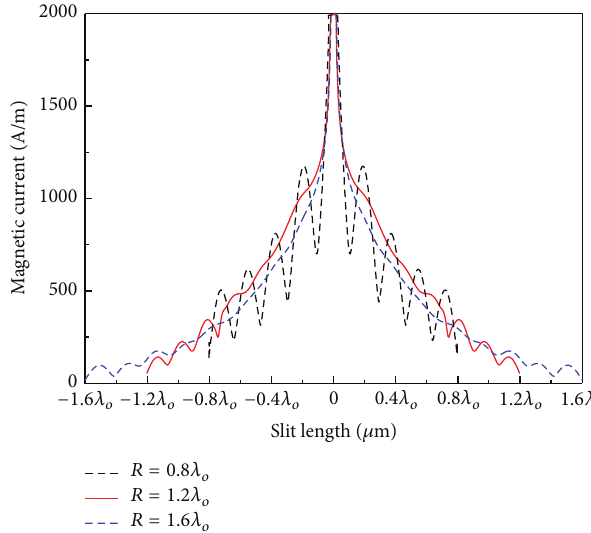
Figure 6: Comparison plots of current distribution for different values of 𝑅 with 𝑇/𝑅 = 0.34 along the slit line at 0.3 THz.